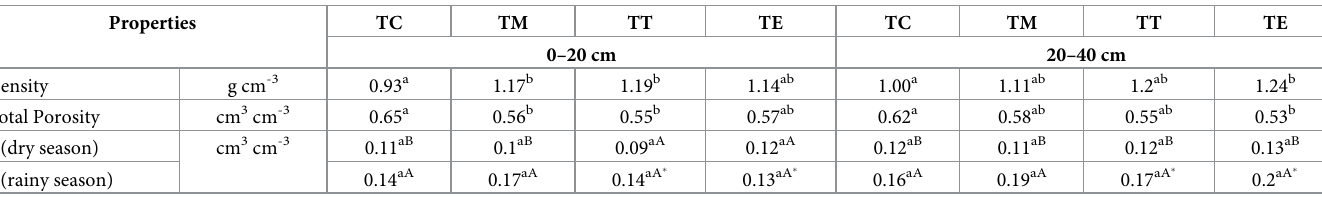
values occurring in the subsurface layer (20–40 cm) during the rainy season (F = 11.25, p = 0.00 and F = 25.95; p = 0.00, respectively). There were also significant differences for this variable when the seasons were compared. For the surface layer, the paired tests indicated higher θ values in the rainy season (October to Table 2. Physical characteristics of the soil in the Cerrado and different types of gravel collection points for the substrate at two depths in Paracatu-MG.